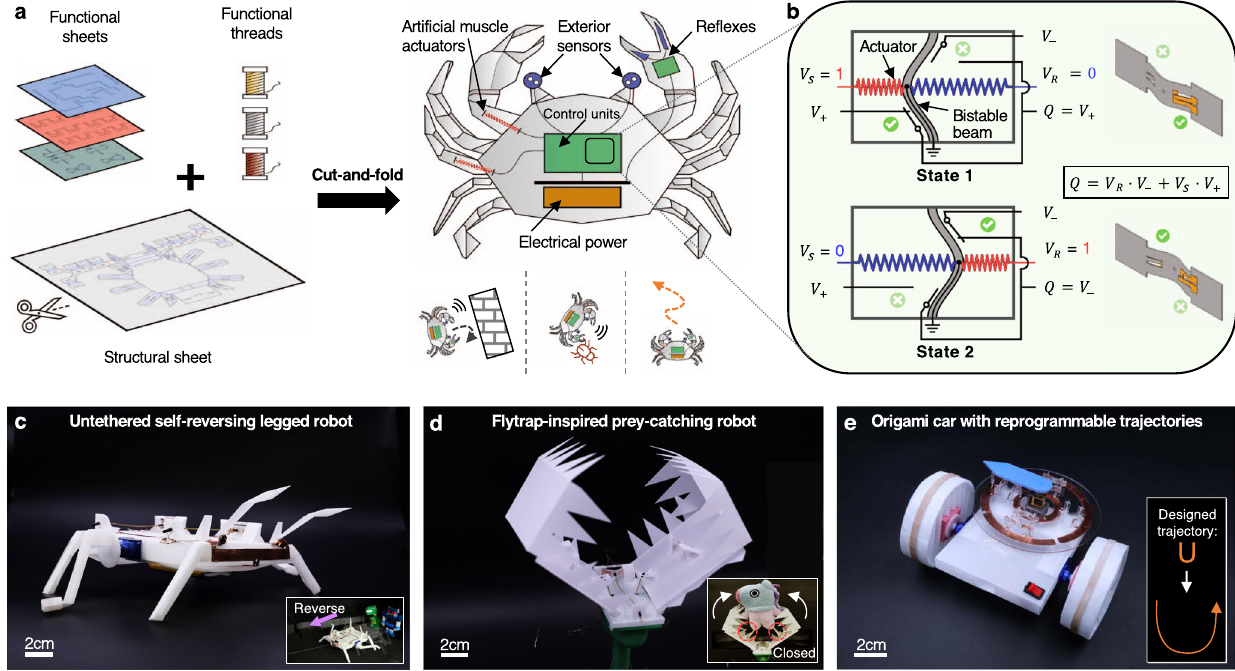
Fig. 1 | Autonomous robots with sensing, computing, and actuating tightly integratedincompliantorigamimaterials.a Aconceptforanautonomousrobot entirely created from functional sheet materials and threads through cut-and-fold processing. b The fundamental building unit of the autonomous robot is the ori- gami multiplexed switches (OMS). The OMS can select between two input signals (i.e., V + and V − )andforwardtheselectedoneon-demandaccordingtotheselection